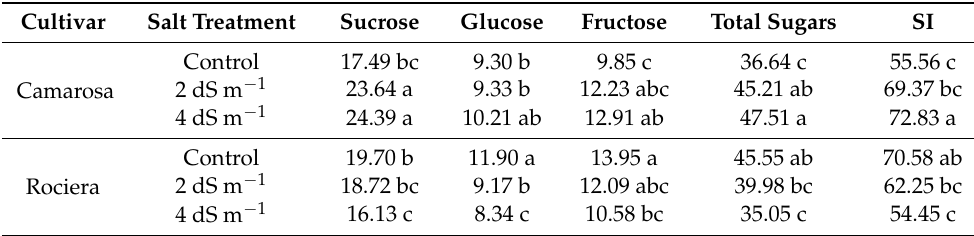
Table 7. Effect of salt stress on strawberry fruit carbohydrate concentration (expressed as mg g − 1 fresh weight) and sweetness index